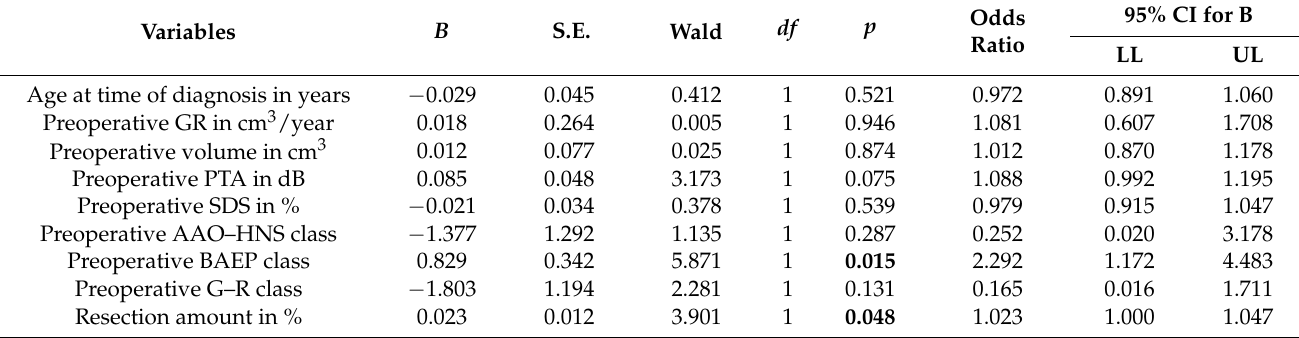
Figure 1. Scattergram of pre-( A ) and postoperative ( B ) hearing results in NF2-associated vestibular schwannomas (VS). Table 4. Logistic regression predicting the likelihood of postoperative hearing deterioration or complete